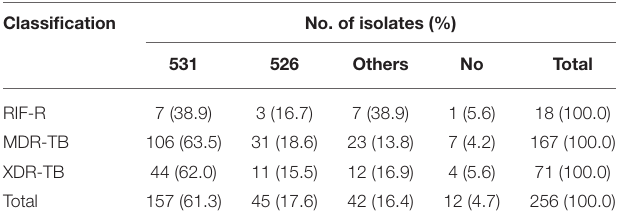
TABLE 2 | Distribution of RIF-resistant isolates harboring different mutations within rpoB gene. Classification